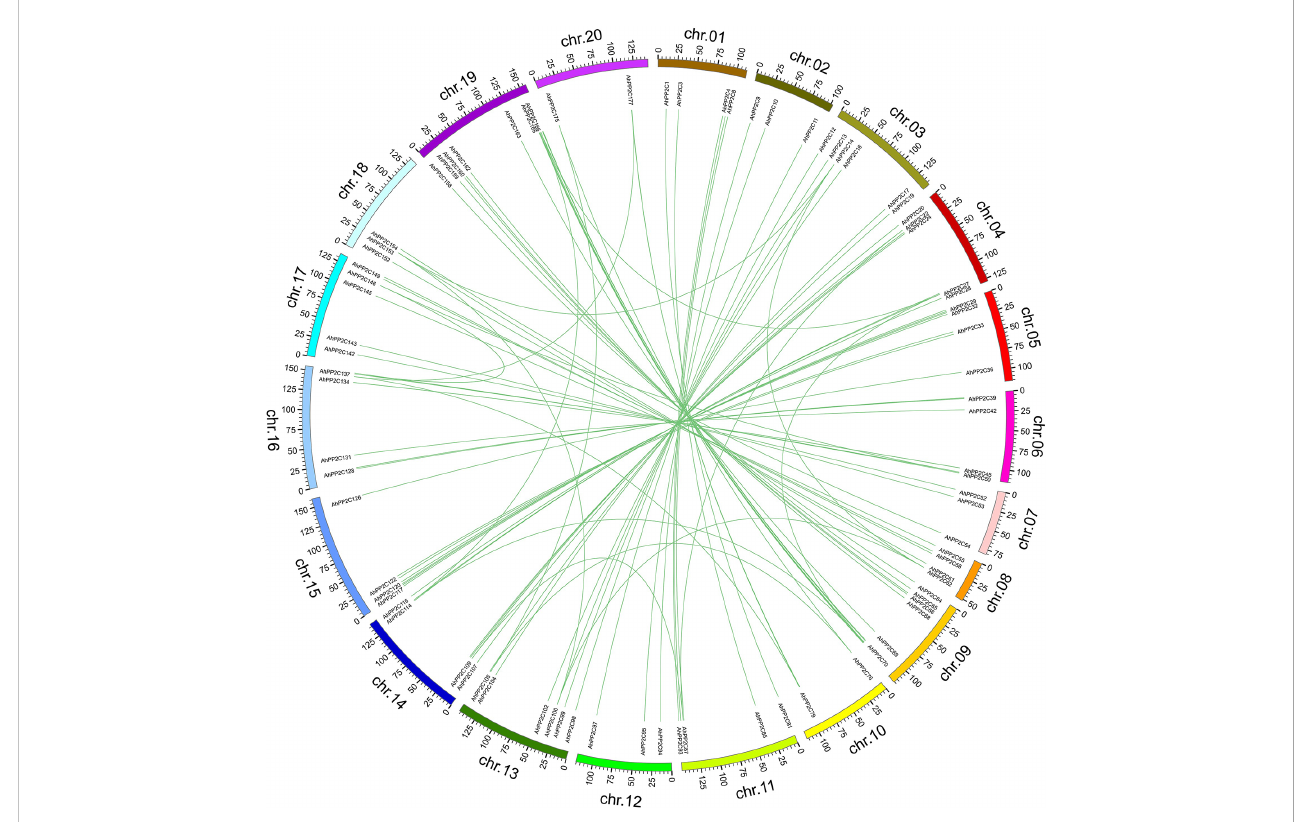
FIGURE 3 Gene duplication analysis of AhPP2C s. Chromosomes are drawn in different colors. The scale provided represents the chromosome size (Mbp). Duplicated AhPP2C s are linked by green